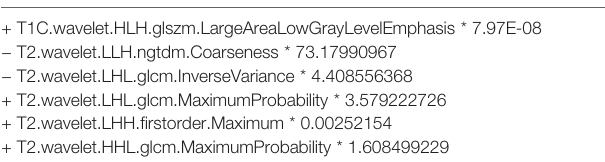
Figure4 .Signi fi cantdifferencesbetweenriskgroupswereobserved